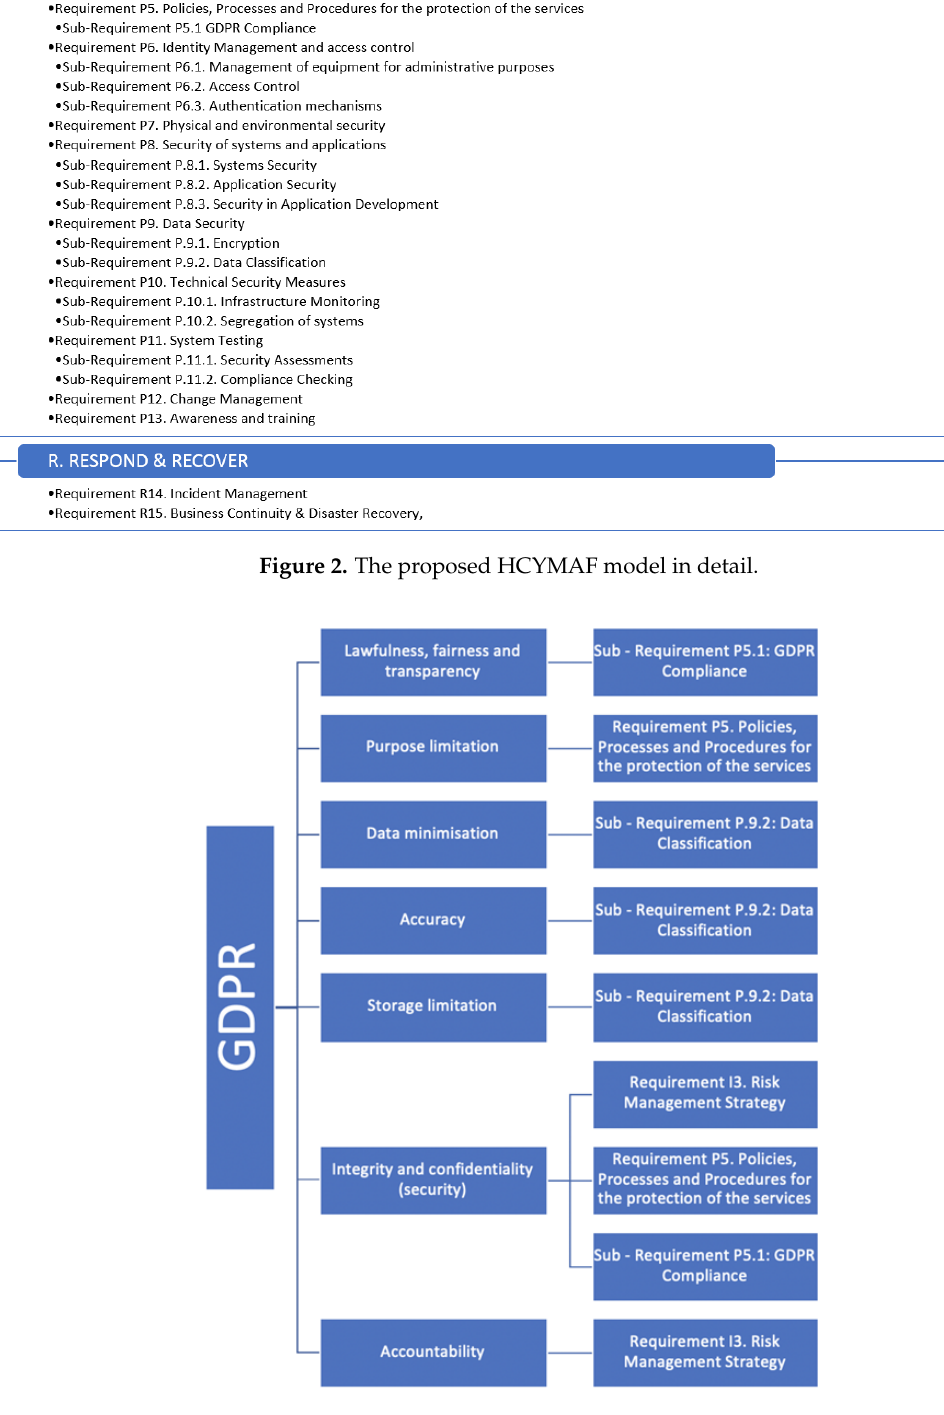
Figure 3. General Data Protection Regulation (GDPR)